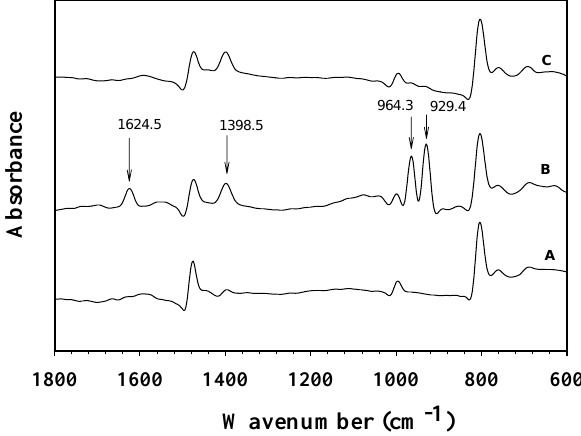
Figure 9. FT-IR spectra of 50:1 dPPP: (A) before; (B) during; and (C) after NH at (28 ± 1) °C and at 1